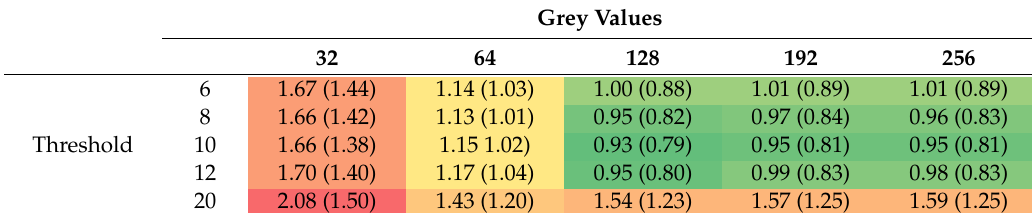
Table 6. Decision support for the identification of the most valuable detector threshold and grey value combination with a priority on the correctly predicted reef area. Values represent the results for a bu ff er size of 1.50 m (3.00 m in parentheses) between the manually and automatically classified stones. Values close to 0.01 are more similar to the manual method. Color scale indicates good values in green and bad values in red.